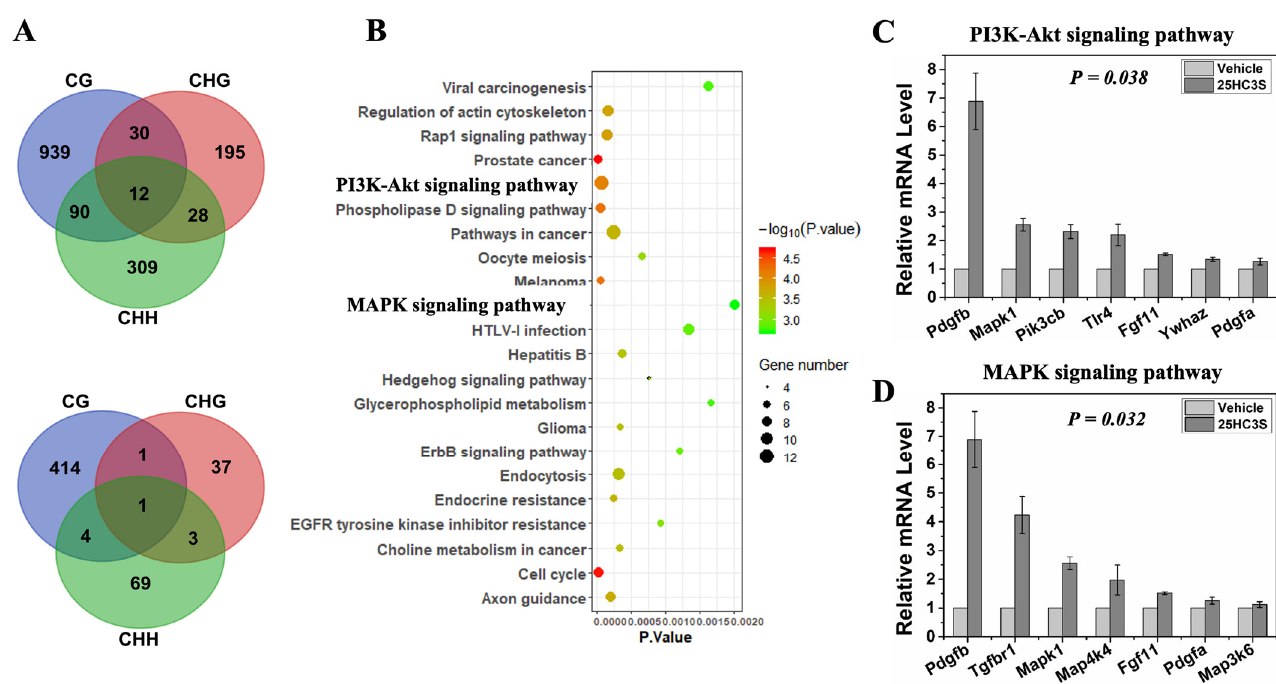
Figure 4. Effects of 25HC3S on DNA methylation in APAP induced liver injury mouse model by global methylation se- quencing analysis. 12-week-old male C57BL/6J mice were intraperitoneally injected with 350 mg/kg APAP, half an hour